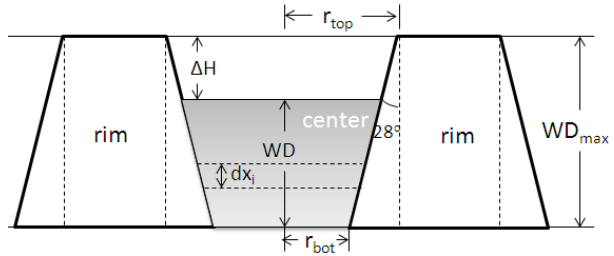
Figure A3. Diagram of rim and polygon center or lake, which are separated by vertical dashed lines. r top is the radius of the top and r bot that of the bottom of a polygon center or lake; WD, WD max and 1H are the water depth, maximum water depth, and microto- pographic relief height in a polygon center or lake,